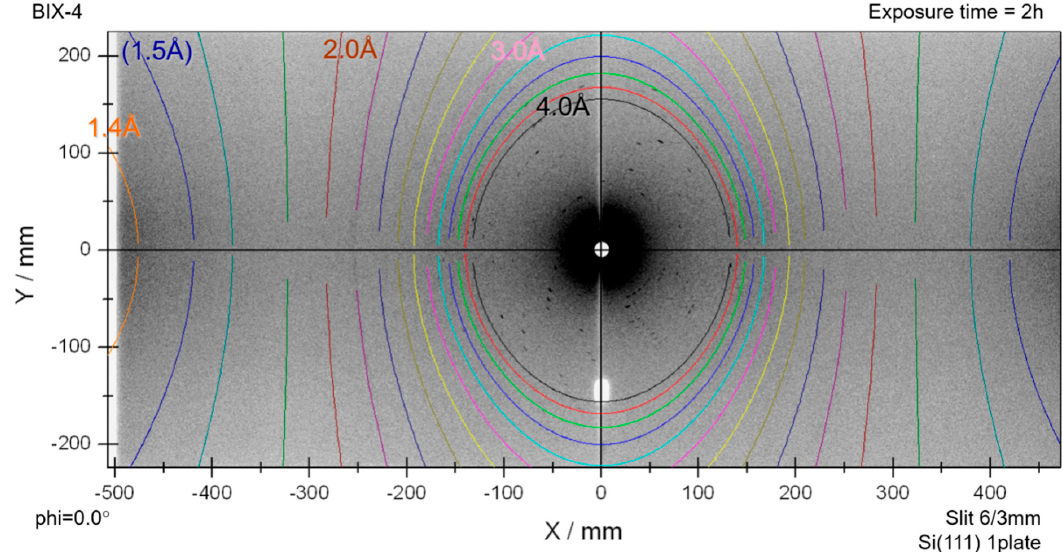
Figure 11. HEWL neutron diffraction pattern determined using previous devices (in BIX-4, Japan). Resolution limit, 100 − 3.0 Å; and mosaicity, 1.0°.